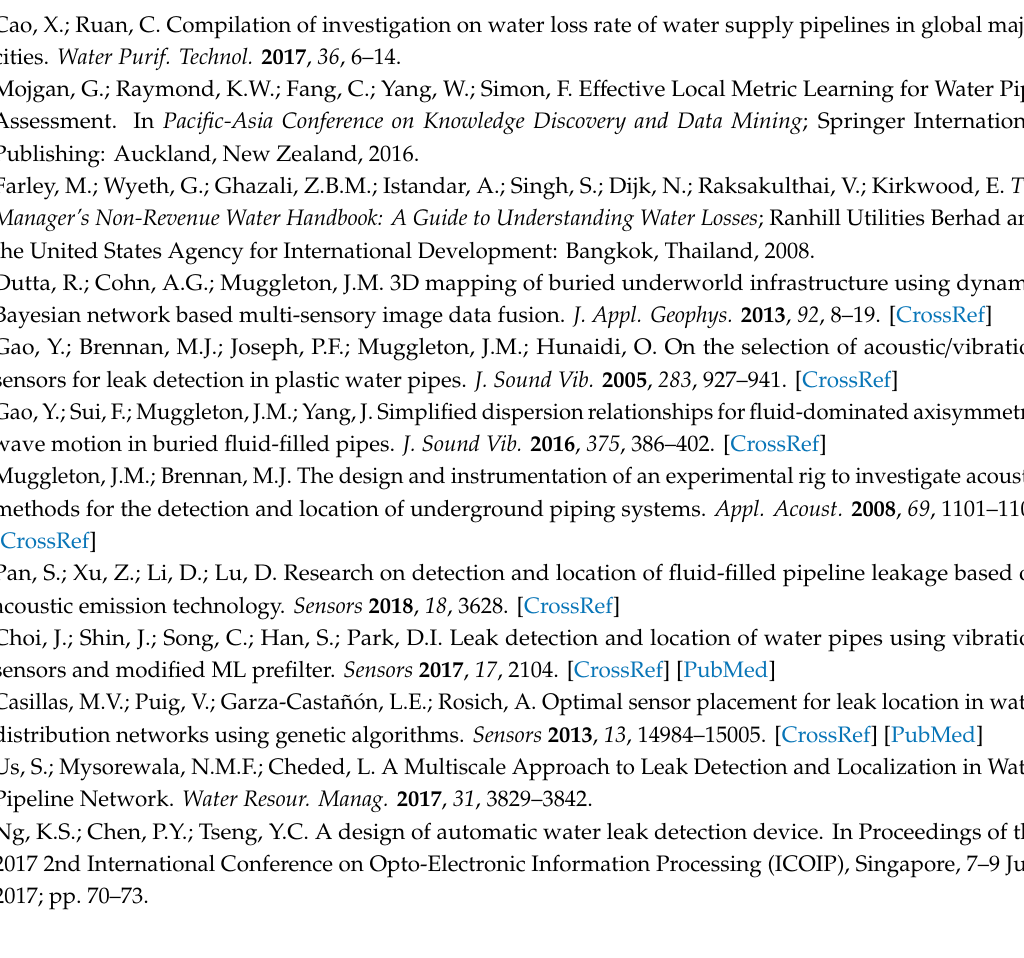
Figure A3. Determination of the excitation point after image fusion.